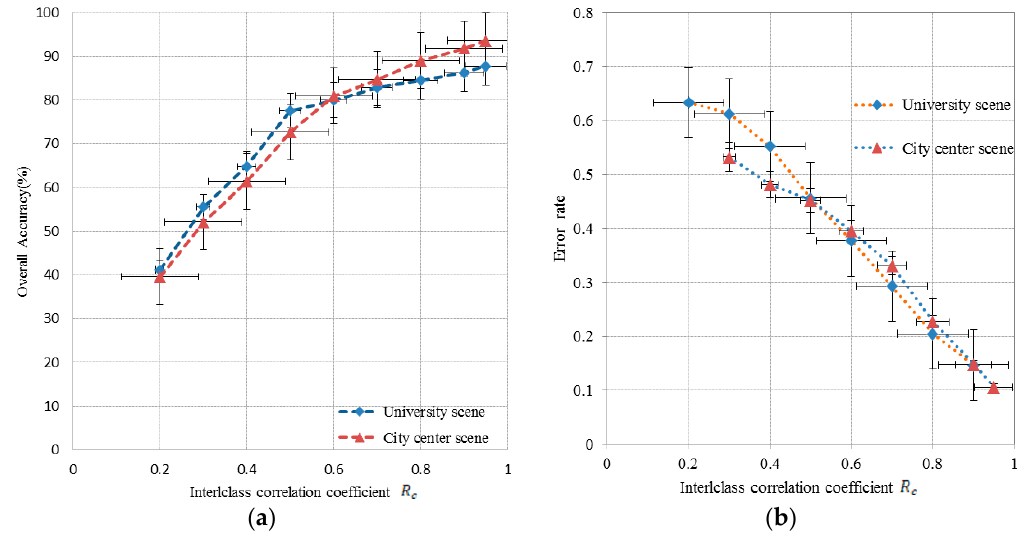
Figure 9. Different results of classification and neighbor points error with interclass correlation coefficient R c : ( a ) overall accuracy with change of R c ; and ( b ) interclass classification error rate with change of R c .